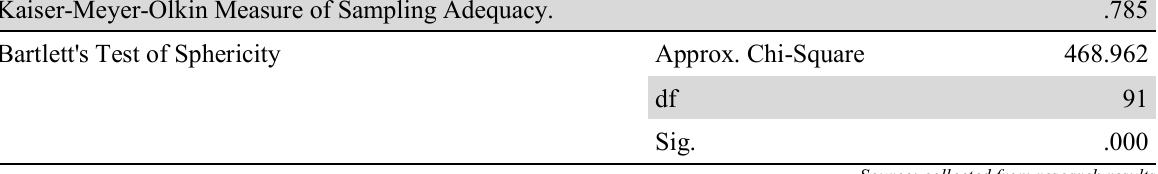
The result of the total variation of the explained data Initial Eigenvalues Extraction Sums of Squared Loadings Rotation Sums of Squared Loadings Component % of Var- Cumulative Total iance % Total % of Variance Cumulative % Total % of Variance Cumulative